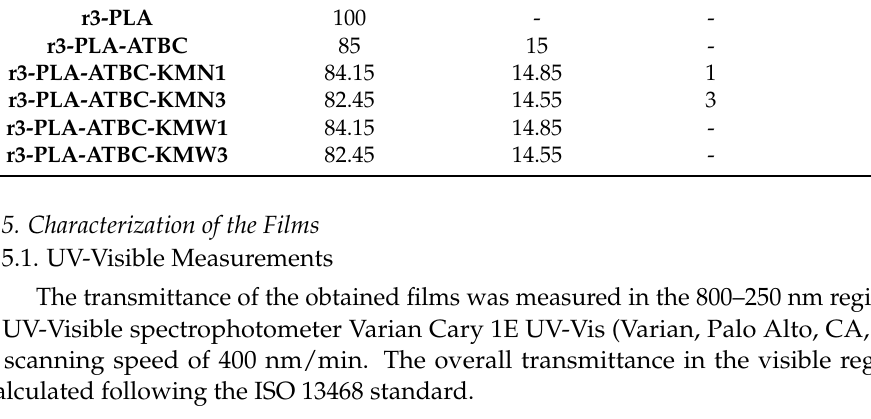
Table 1. Film formulations based on plasticized 3r-PLA-ATBC. Sample r3-PLA (wt.%) ATBC (wt.%) KMN